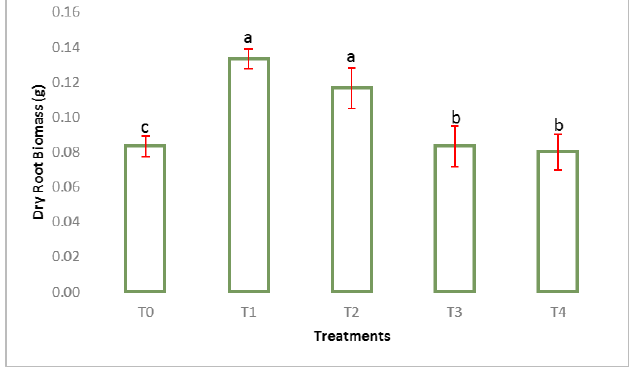
Figure 10: Dry Root Biomass